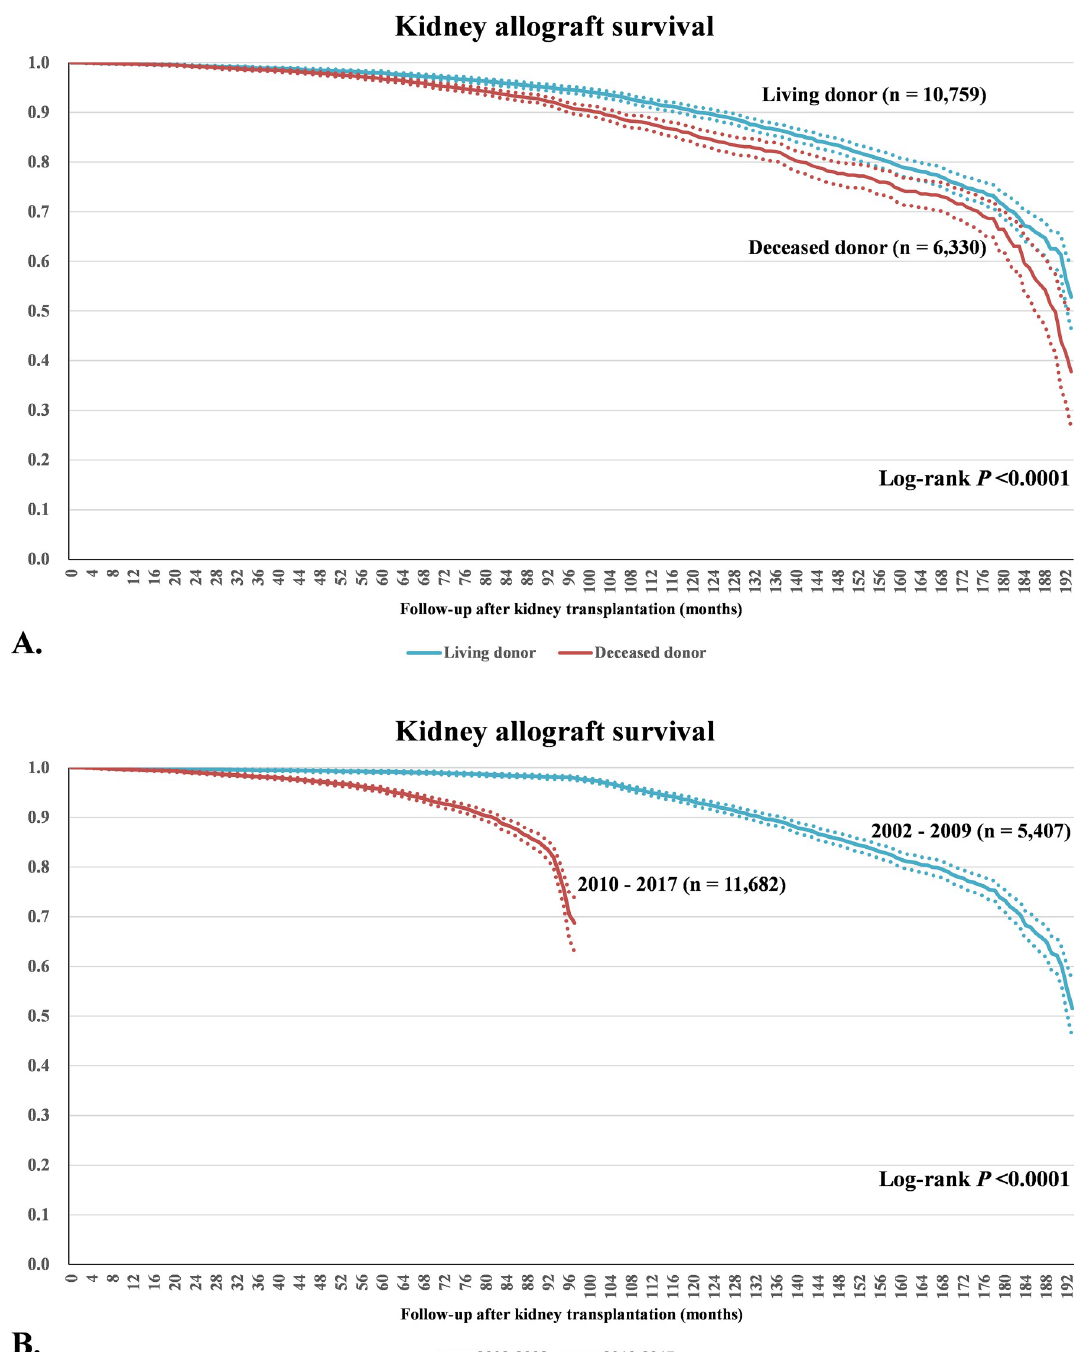
Fig 3. Graft survival after kidney transplant over 16 years. Dashed lines demonstrate 95% confidence intervals of the graft survival